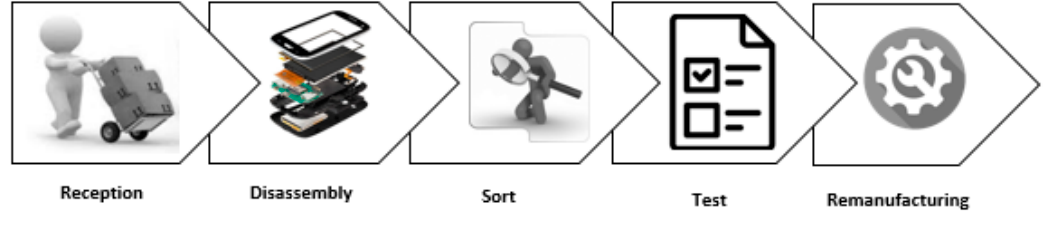
Figure 2. Different steps of having remanufacturing parts.